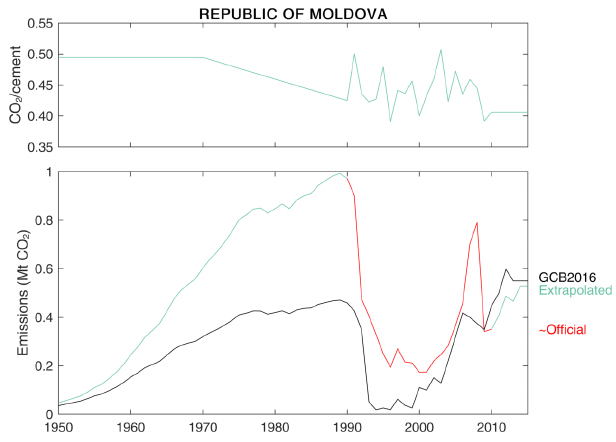
Figure D25. Revised cement emissions for Moldova.